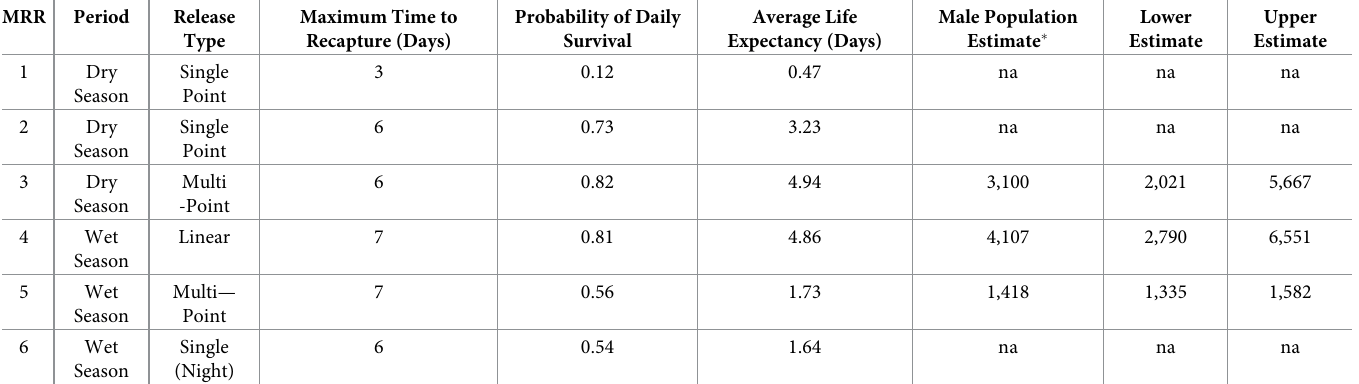
Table 2. Probability of daily survival, average life expectancy and population estimates from rhodamine B marked Aedes aegypti during six mark-release-recapture experiments in South Innisfail, Australia. Wild male population sizes were estimated via the Lincoln Peterson Index [8] and probability of daily survival and average life expectancy via the methods of Gillies [40] and Niebylski and Craig Jr [41].